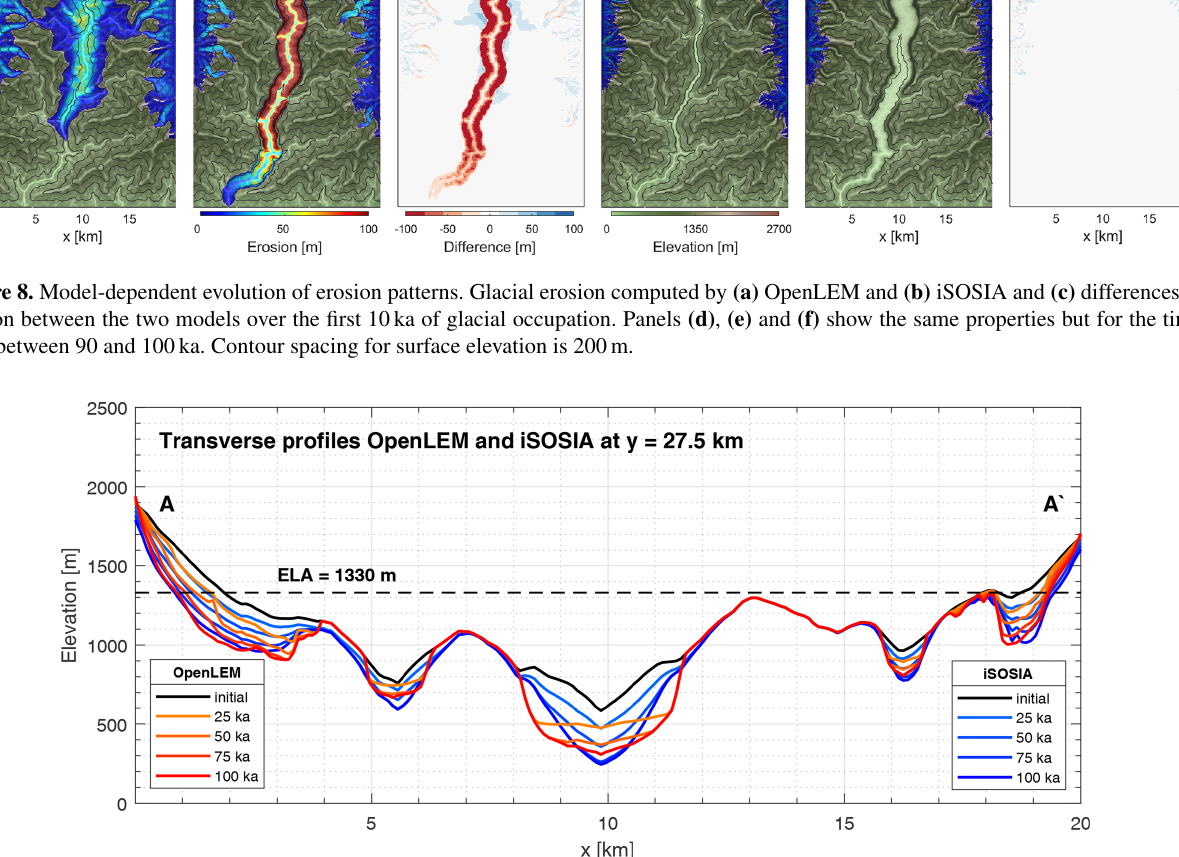
Figure 9. Time series of the evolution of the transverse profiles in the OpenLEM and iSOSIA experiment shown as red and blue lines, respectively. The position of the cross section is depicted in Fig.